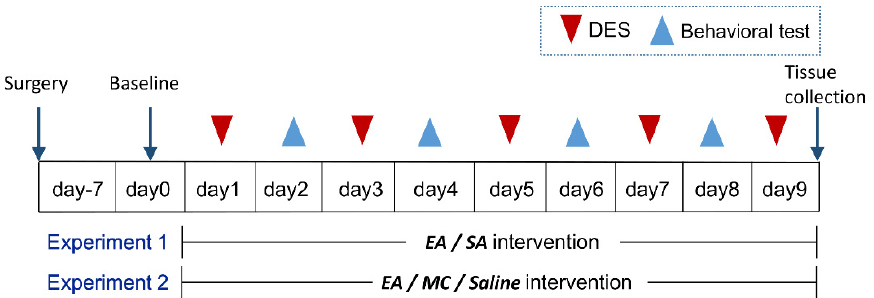
Figure 1. Schematic representation of the experimental protocol. After the post-surgery recovery (7 days), rats received repeated DES every 2 days (day 1, 3, 5, 7 and 9). EA at GB20/sham-acupoint (Experiment 1) and MC/saline systemic administration (Experiment 2) were performed every day from day 1 to 9. Facia mechanical threshold were assessed on day 0 (baseline), 2, 4, 6, and 8 by electronic von-Frey. Tissue and specimen collection were conducted on day 9 after the last intervention.